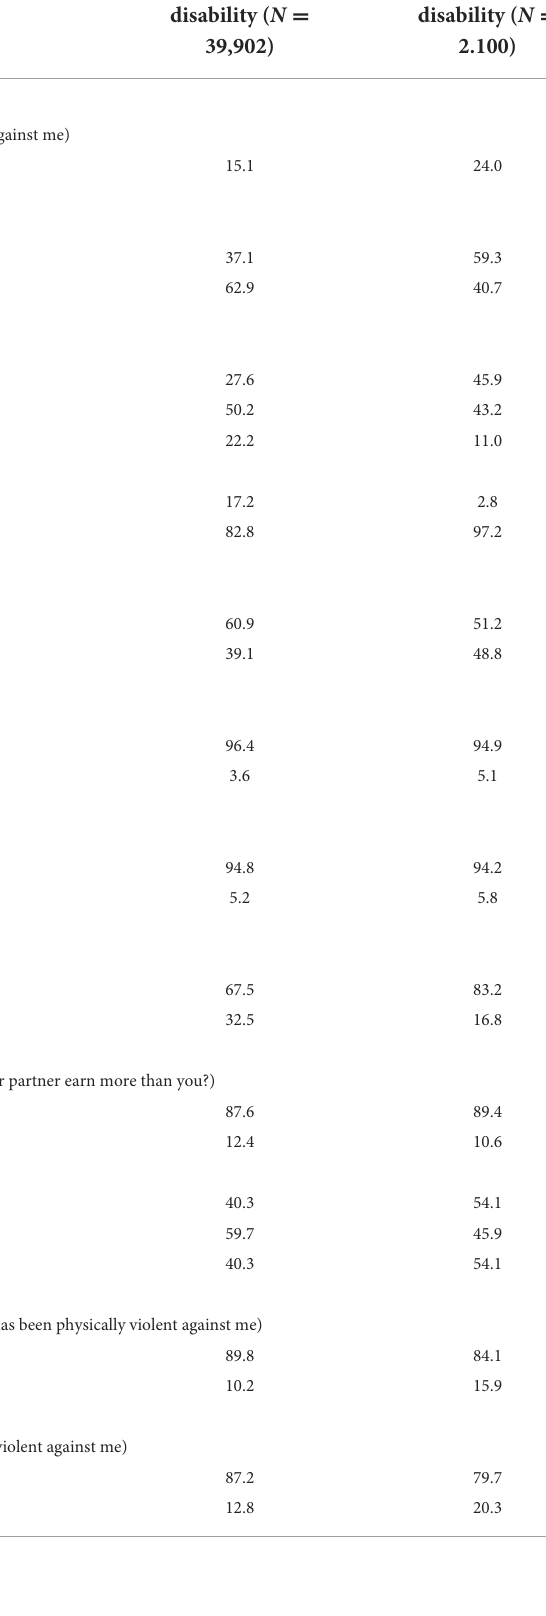
TABLE 1 Descriptive of living with (without) a disability